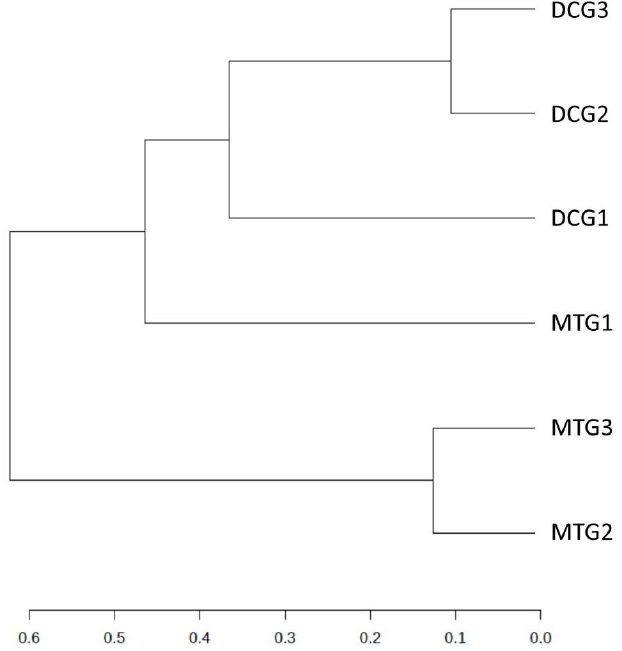
Figure 5. Dendrogram analysis at the DC/MT generations using the Bray – Curtis index and the ward clustering algorithm.